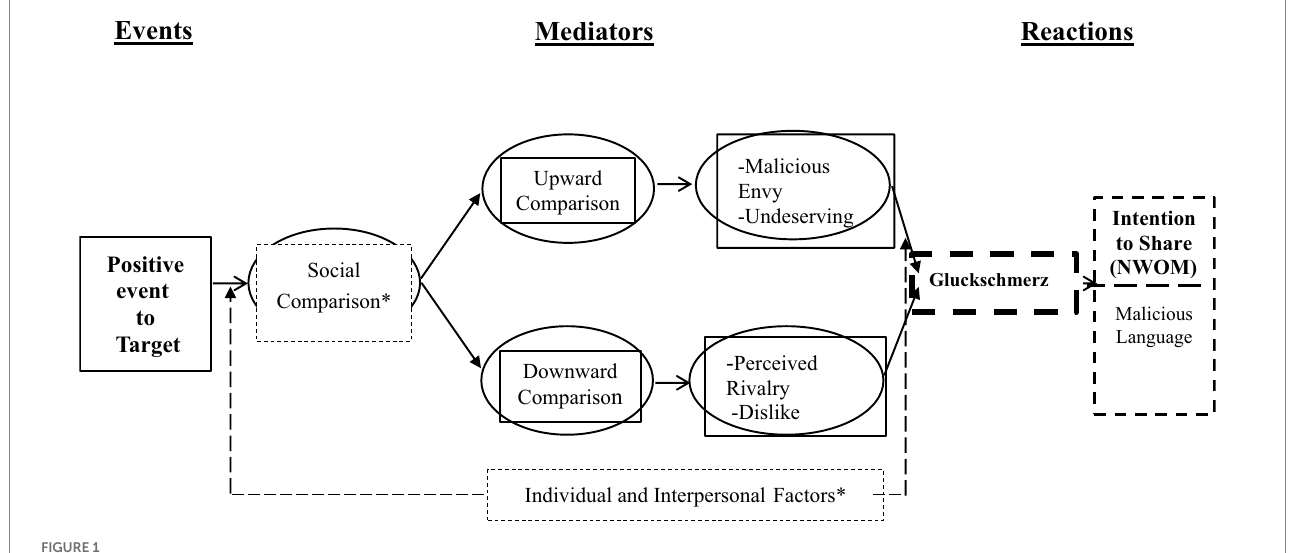
FIGURE 1 Conceptual framework. *Not treated in this study–for future research.